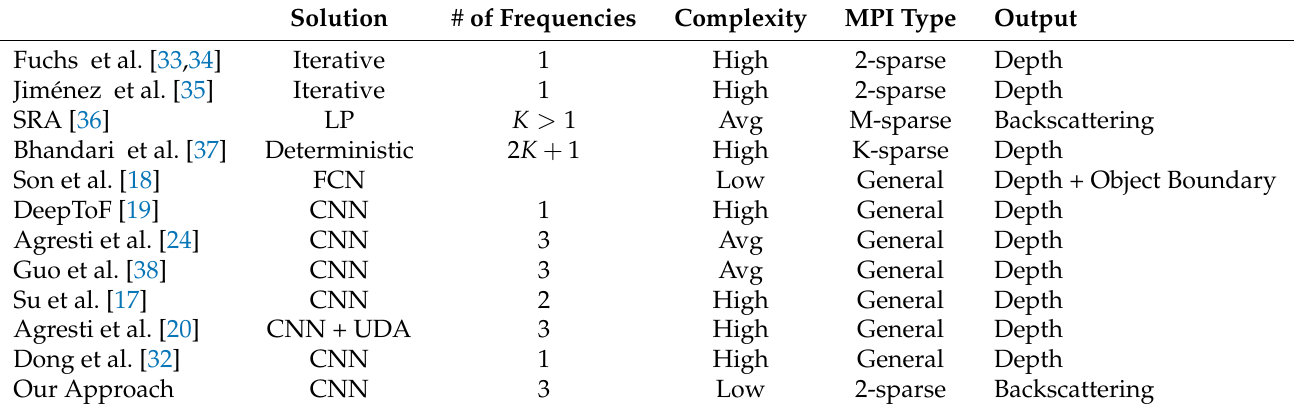
Table 1. Summary of the main state-of-the-art Multi-Path Interference (MPI) correction